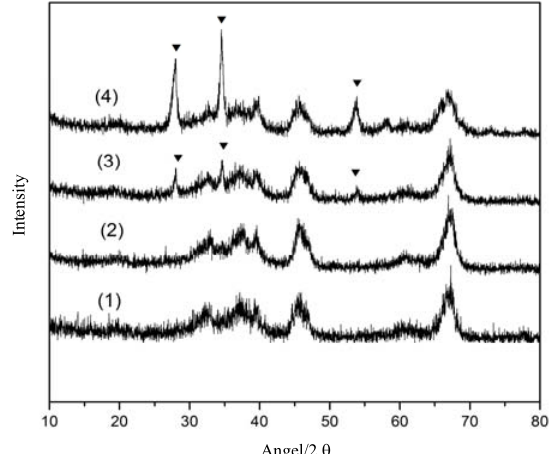
O with different Ir contents: (1) zero, (2)0.1wt.%, (3) 2 3 ( ▼ 2